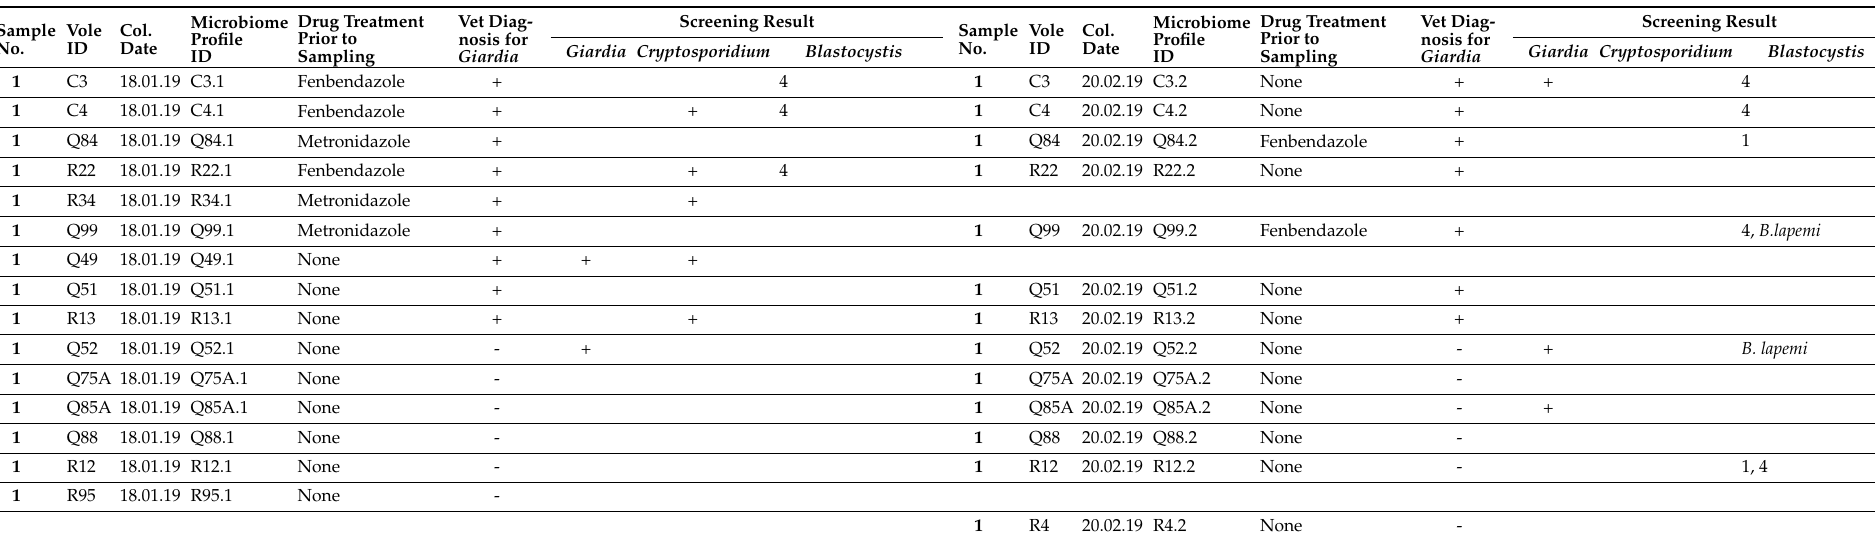
Table 1. Protozoa screening results from the study cohort. Screened parasites included Blastocystis, which was the main focus of this study, in addition to Cryptosporidium sp. and Giardia intestinalis . G. intestinalis was being monitored in the vole population prior to this study, and several of the voles were undergoing treatment for Giardia infection. Sample No.